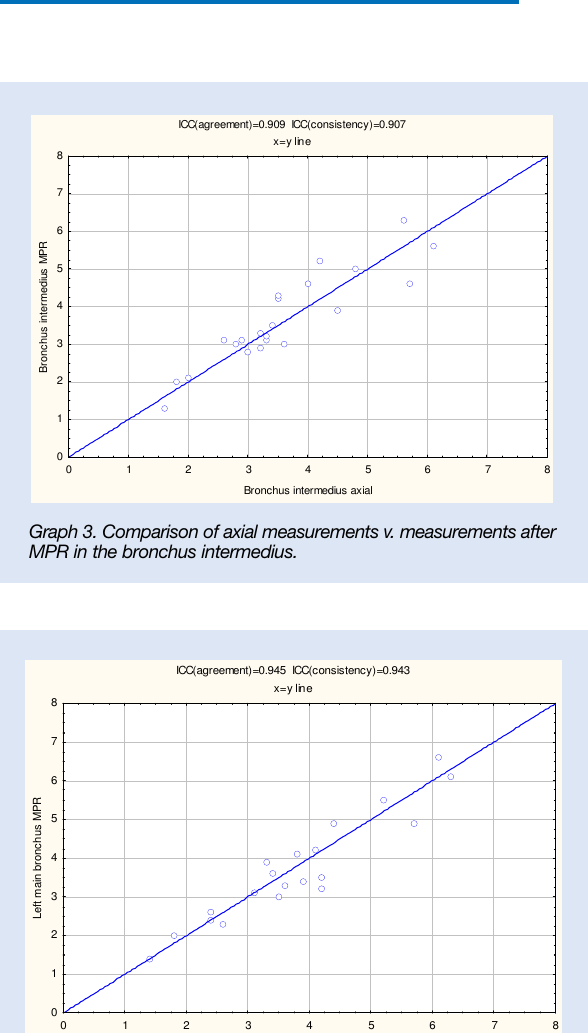
Graph 4. Comparison of axial measurements v. measurements after MPR in the left main bronchus.